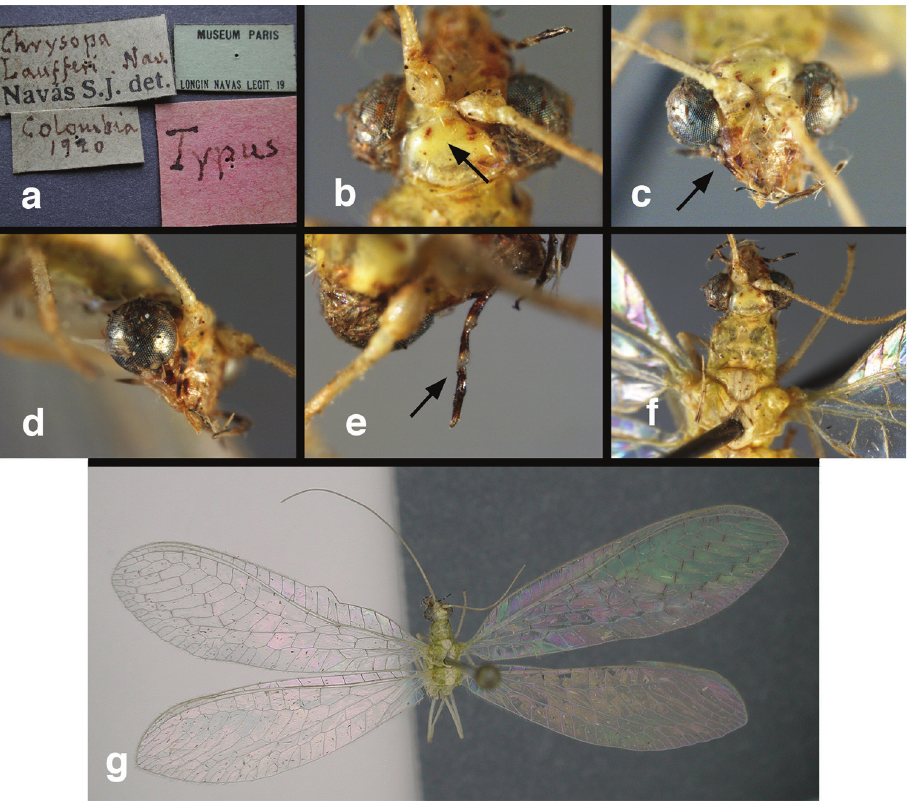
Figure 48. Chrysopa laufferi Navás: External features, ( a ) labels ( b ) head, dorsal [Arrow indicates red dorsal marks on vertex.] ( c ) head, frontal [Arrow indicates red subocular and clypeal marks.] ( d ) head, lateral ( e ) head, dorsal [Arrow indicates labial palp.] ( f ) head, prothorax, mesothorax, dorsal ( g ) habitus with wings (Colombia, no locality, holotype, sex unknown,